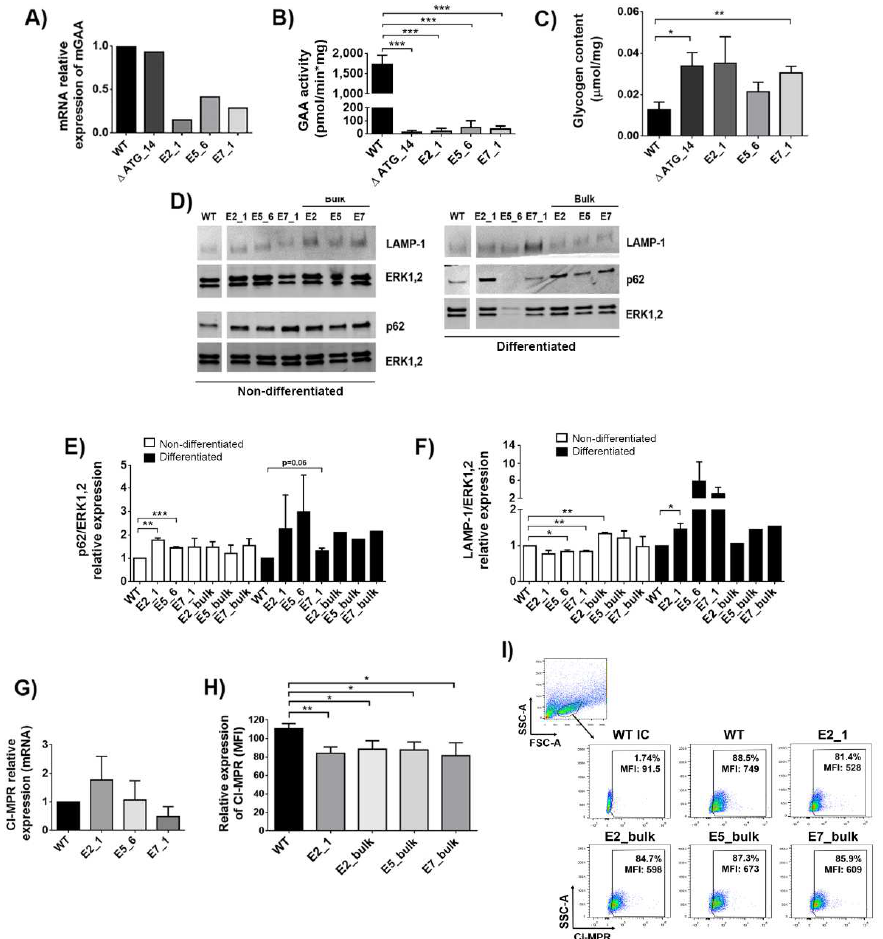
Figure 2. Characterisation of GAA-KO Sol8 cellular models. ( A ) mRNA relative expression of mGAA in the different Sol8 clones ( ∆ ATG_14, E2_1, E5_6 and E7_1) compared to WT cells. ( B ) GAA activity in Sol8 WT cells and mutated clones ( ∆ ATG, E2_1, E5_6 and E7_1). ( C ) Glycogen content in Sol8 myoblasts differentiated into myotubes (see M&M) in WT and clones ( ∆ ATG, E2_1, E5_6 and E7_1). ( D ) Western blot analysis of Sol8 cells lysates using anti-p62/sequestosome-1 (SQSTM1) and anti-LAMP-1 antibodies. Anti-ERK1,2 was used as a loading control. ( E ) Quantification of p62 levels normalised to ERK1,2. ( F ) Quantification of LAMP-1 levels normalised to ERK1,2. ( G ) mRNA relative expression of CI-MPRs in clones ( ∆ ATG, E2_1, E5_6 and E7_1) and Sol8 WT cells. ( H ) Surface CI-MPRs relative expression (mean fluorescence of intensity-MFI) in Sol8 WT compared to E2_1, E2_bulk, E5_bulk and E7_bulk. ( I ) Representative dot-plot of CI-MPRs expression (MFI) in Sol8 WT, E2_1, E2_bulk, E5_bulk and E7_bulk. Statistical analyses: unpaired t-test, two-tails ( A – C ), unpaired t-test one-tail ( E – H ) (* p < 0.05, ** p < 0.01, *** p < 0.001. Values represent means +/ − SEM of at least 3 separate